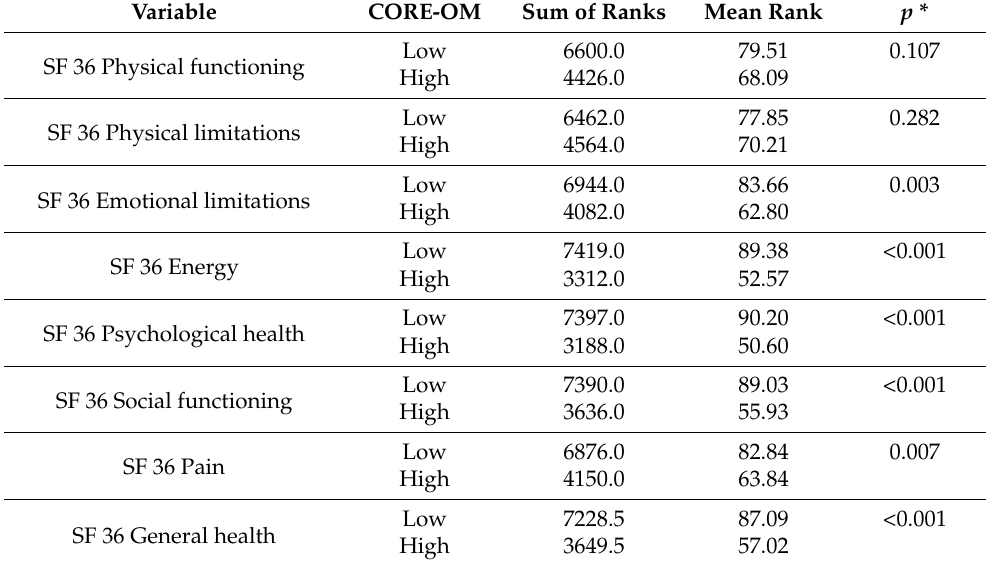
Table 3. Differences in the SF-36 subscales considering high ( n = 65) and low ( n = 83) levels of mental distress (CORE-OM) ( n =